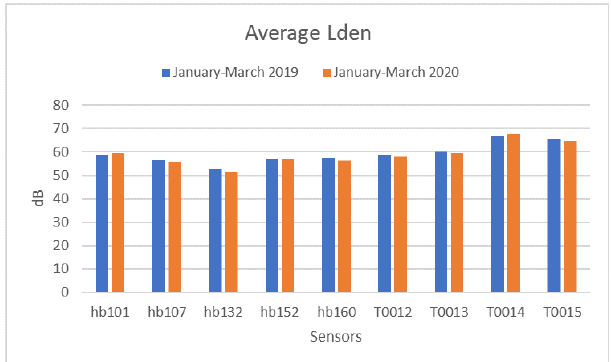
Figure 13: Comparison between weakly average Lden values for the